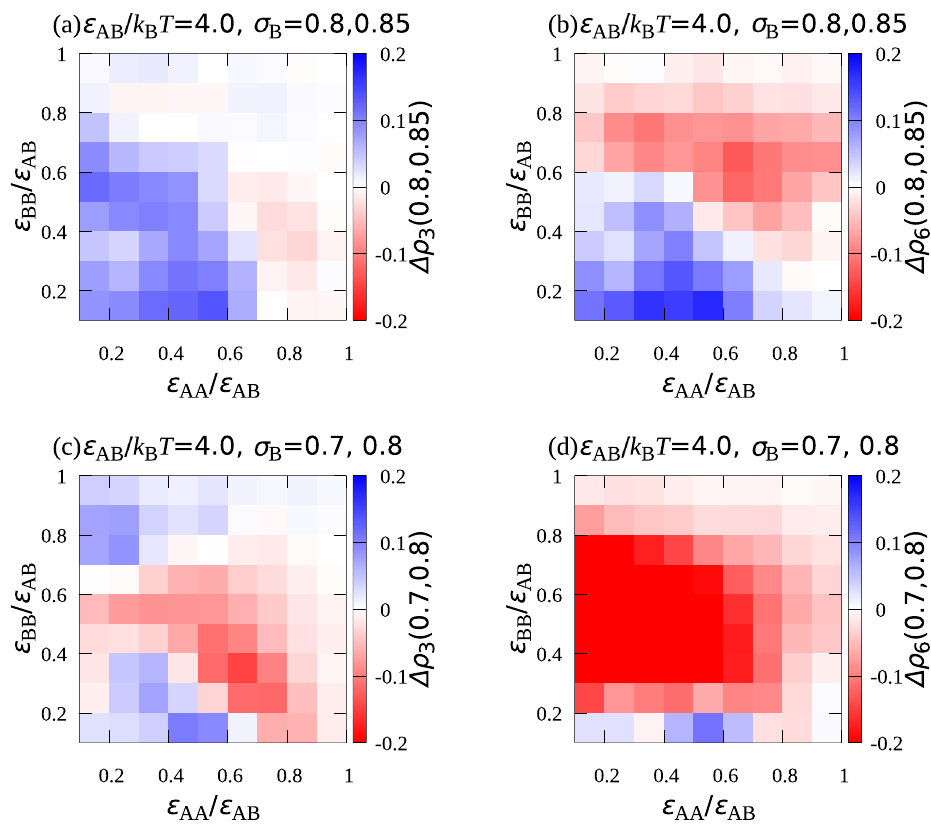
Figure 4. Difference between ( a ) ρ 3 in the system with σ B = 0.8 and that in the system with σ B = 0.85 , ( b ) ρ 6 in the system with σ B = 0.8 and that in the system with σ B = 0.85 , ( c ) ρ 3 in the system with σ B = 0.7 and that in the system with σ B = 0.8 , and ( d ) ρ 6 in the system with σ B = 0.7 and that in the system σ B = 0.8, where σ A was set to unity.